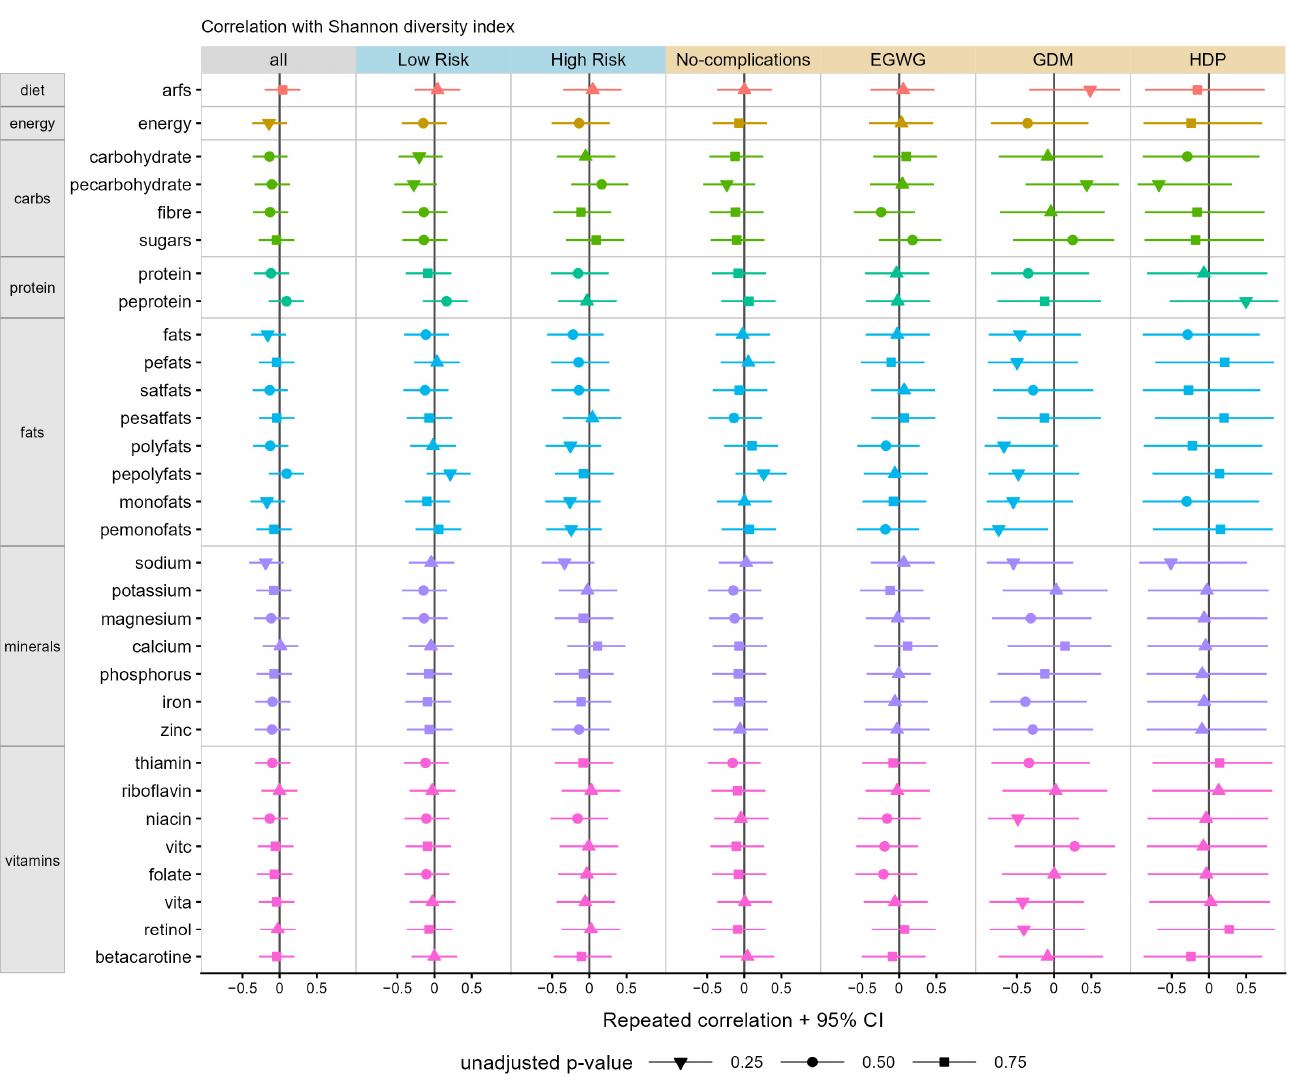
Figure 3. Correlation of microbial Shannon diversity with diet and nutritional factors. Point ranges show the coefficients and 95% confidence intervals measured by repeated-measures correlation (rmcorr R package). Diet and nutritional factors are shown in separate rows and colour coded (orange row: diet quality; mustard row: energy; green rows: carbohydrates and sugars; aqua rows: protein; blue rows: fats; purple rows: minerals; pink rows: vitamins), while correlations were performed using the entire cohort (all); cohort based on low- and high-risk pregnancies (blue panels) and cohort separated by pregnancy outcomes (orange panels). The shape of the point represents the unadjusted p -value as indicated by the legend. Abbreviations: EGWG—excessive gestational weight gain; GDM—gestational diabetes mellitus; HDP—hypertensive disorder of pregnancy.